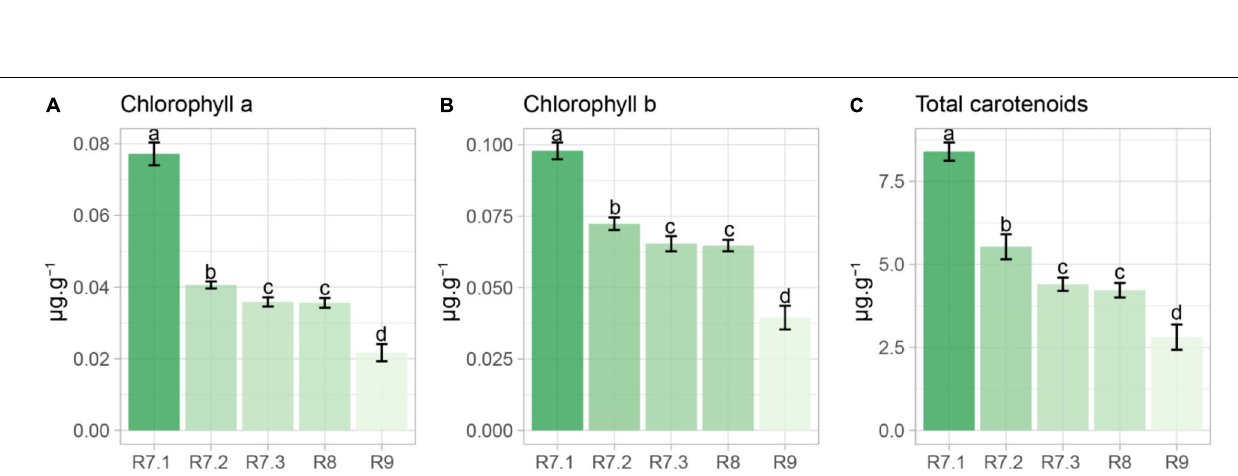
Frontiers in Plant Science |